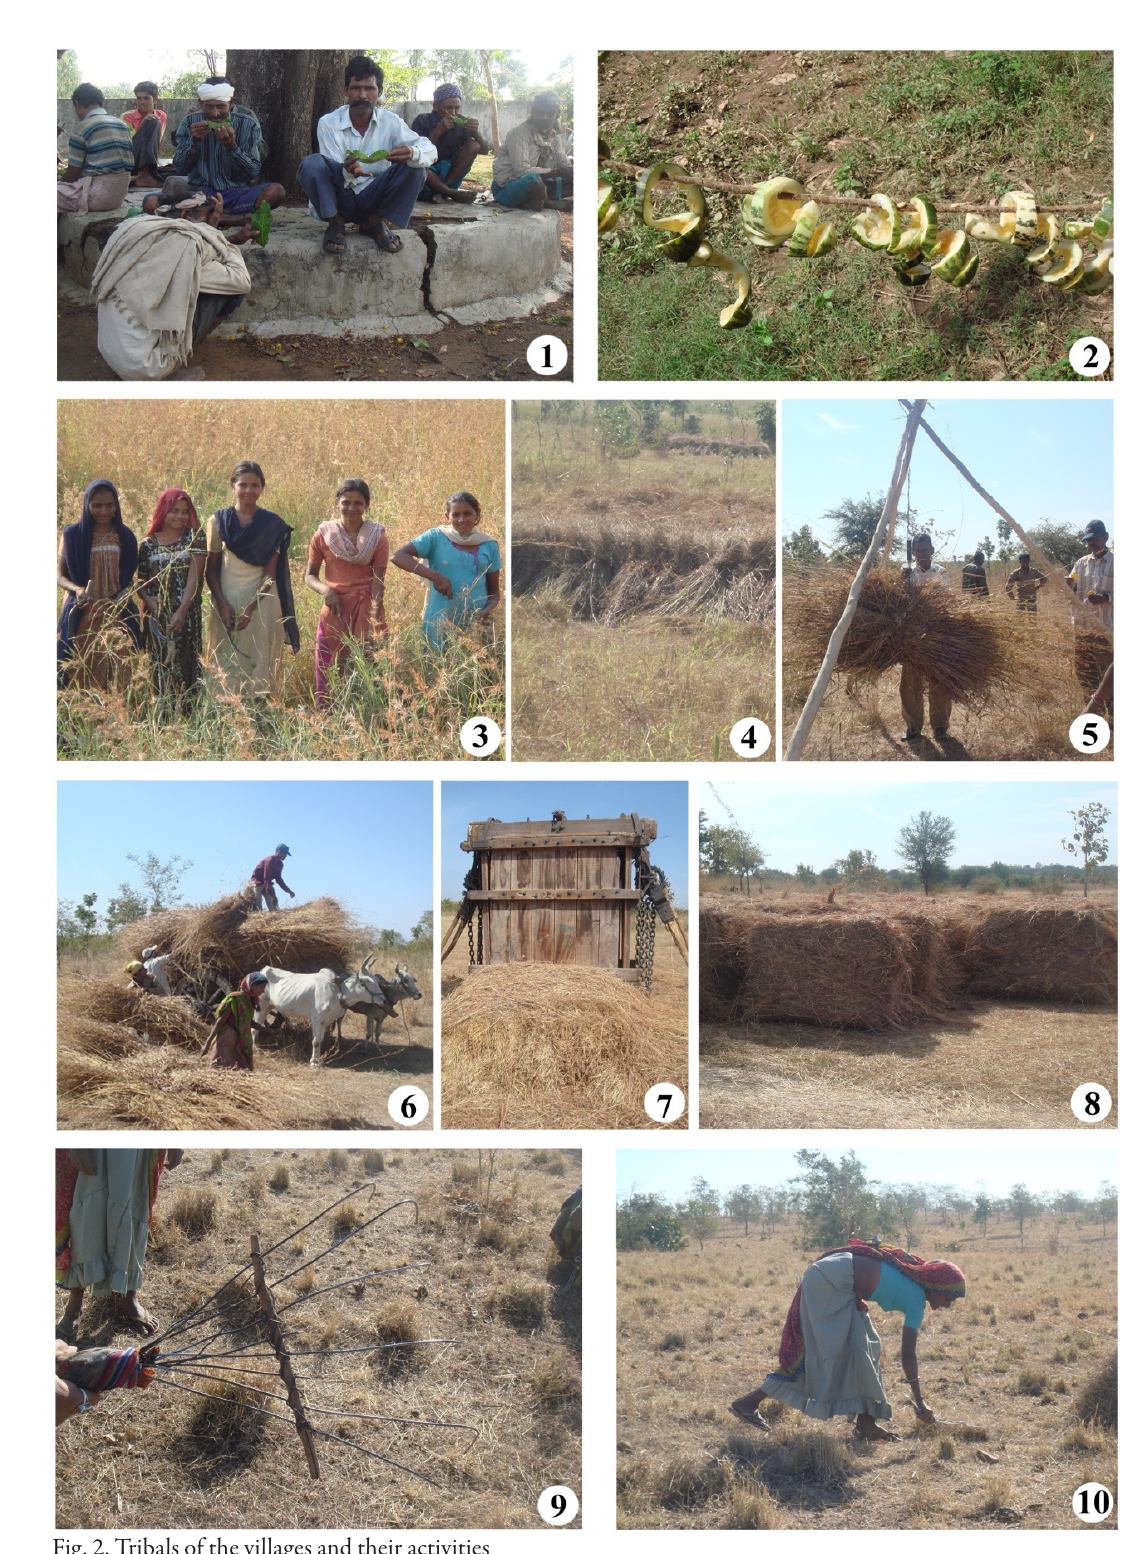
Fig. 2. Tribals of the villages and their activities 1. Tribal people of Kantu using leaves of Madhuca indica as bowl; 2. Drying of cucurbits on ropes; 3. Tribal people of Rampura cutting grasses; 4. Storing of gansdi (baled grass); 5. Forest officials weighing gansdi; 6. Transportation of gansdi by bullock cart; 7. Pressing machine to bale the grasses; 8. Baled grasses stored; 9. Handmade equipment used for collection of grasses; 10. Tribal people collecting